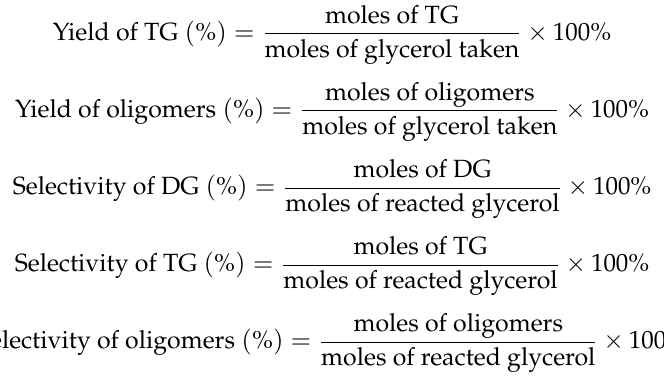
FT-IR spectra. Figure S4: XRD patterns of (a) XZ-Na and (b) XZ-K. Figure S5: EDX data of XZ-Na (a) pristine, (b) after 5th recycle, (c) after 10th recycle and XZ-K (d) pristine, (e) after 5th recycle, (f) after 10th recycle, respectively. Table S1: Structural characterization. Table S2: Recycling